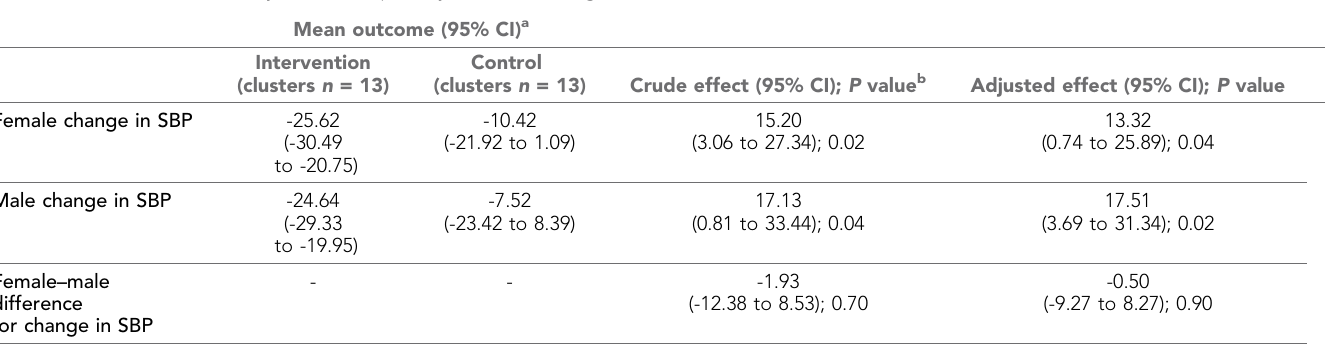
Table 3. Effect modification by sex for the primary outcome (change in